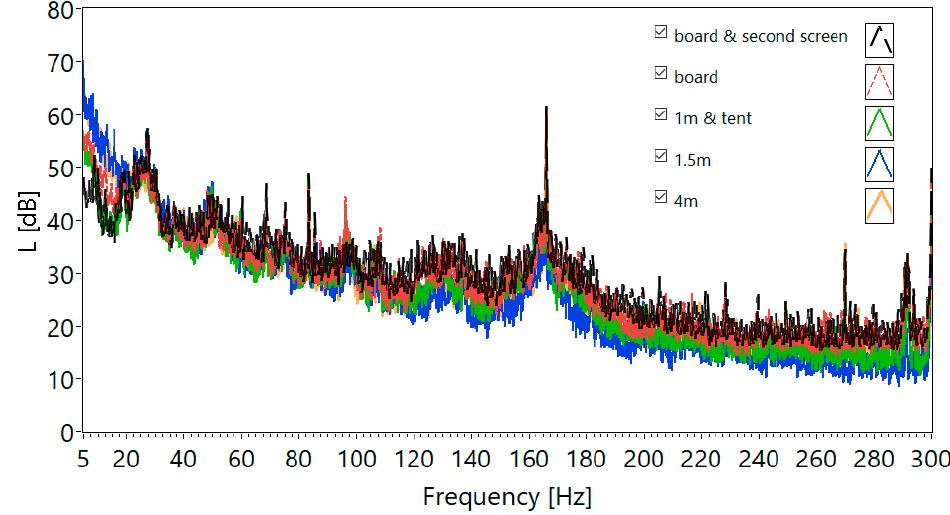
Figure 8. Ventilation shaft noise. Amplitude-frequency spectrum—average wind speed 5.0 m/s.